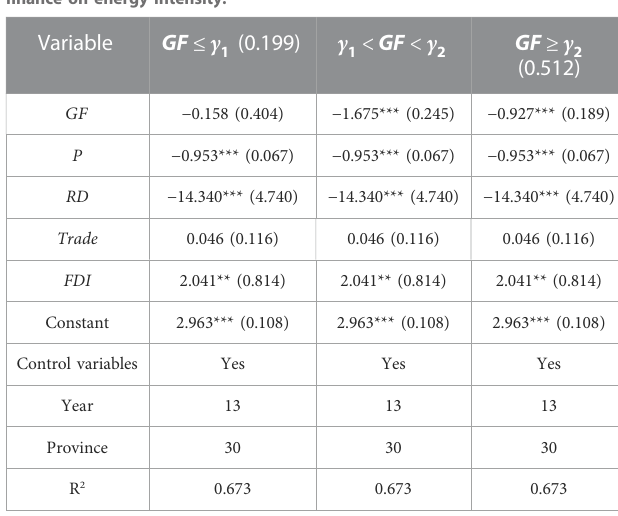
TABLE 3 Regression results of the threshold model for the impact of green fi nance on energy